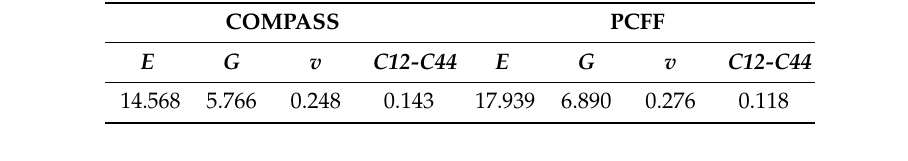
Table 1. Average values of E , G , v , and C12-C44 of properties in a steady state of the cellulose models using different force fields.